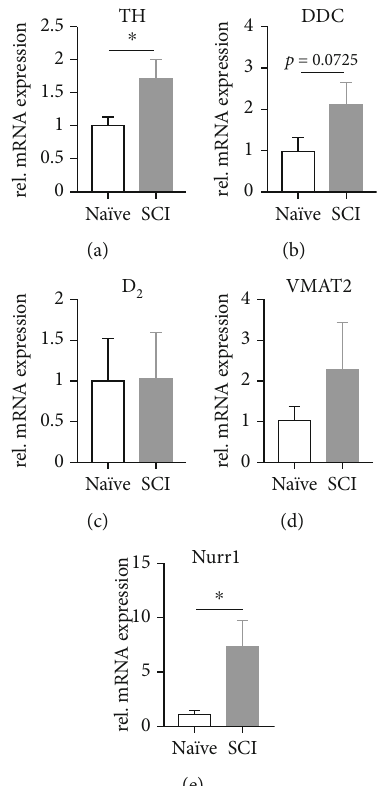
Figure 6: Transcripts of classical DA-ergic enzymes increase in A9 and A10 neurons after SCI. mRNA levels of TH (a) and the transcription factor Nurr1 (e) are upregulated in the A9 and A10 nuclei 3 weeks after SCI. The DDC transcript shows a trend towards signi fi cance (b), while D (c) and VMAT2 (d) do not change. ∗ p < 0 : 05 . 2